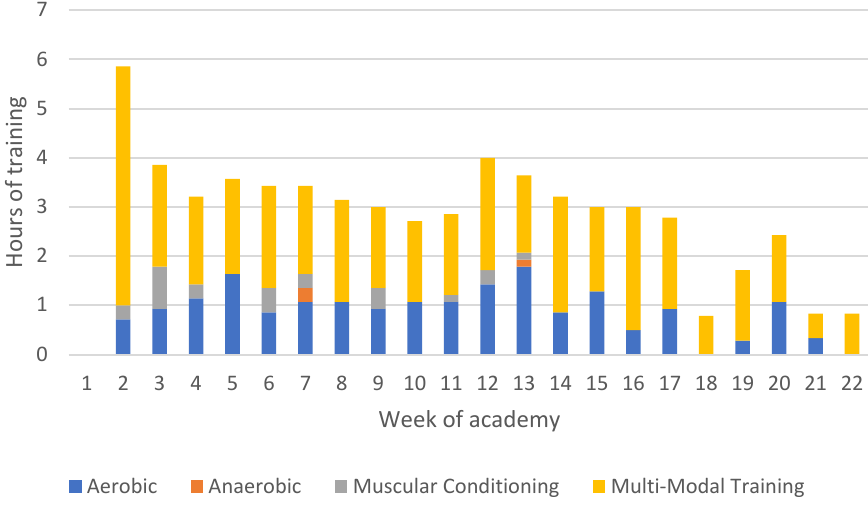
Figure 6. Average hours of class and skill training per week across seven academy classes.